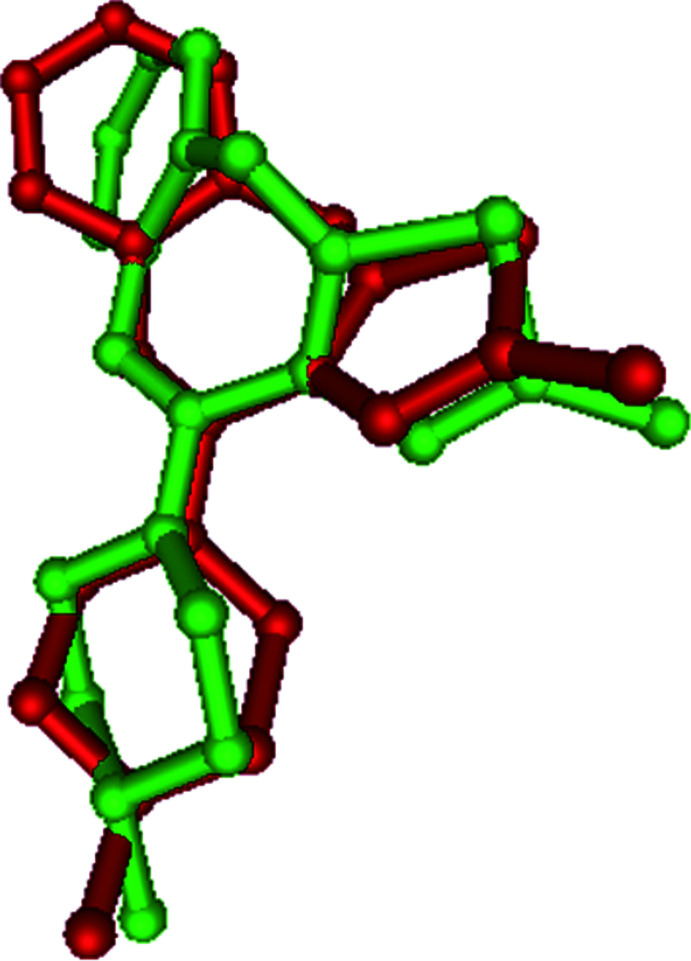
A superimposed fit of (I) (red) and the related structure (III) (green).